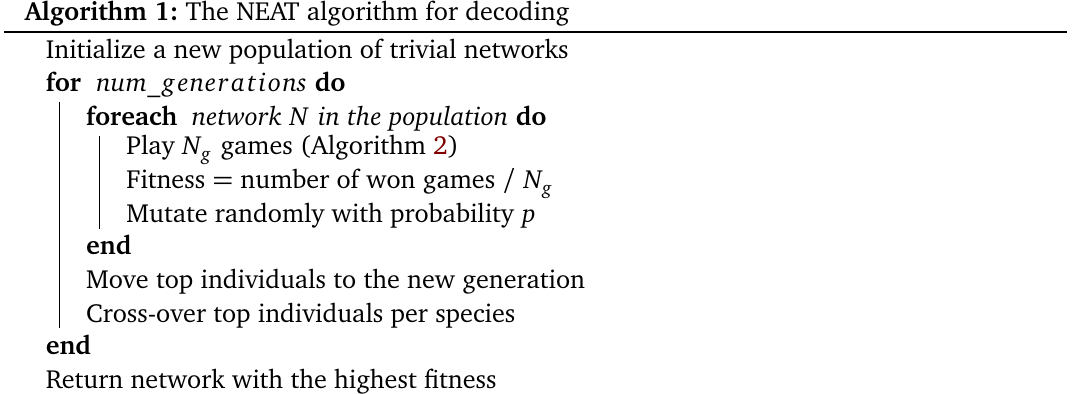
Algorithm 1: The NEAT algorithm for